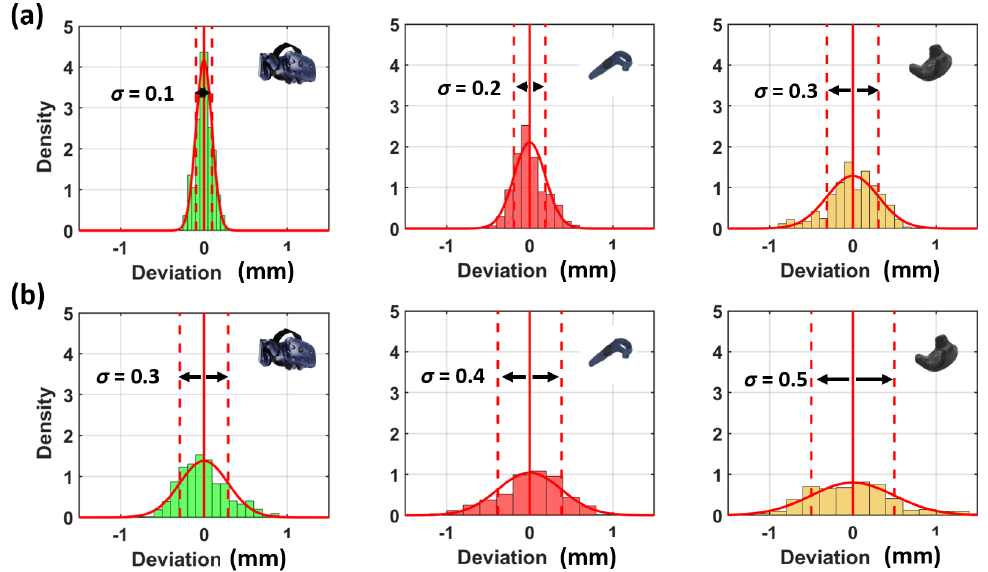
Figure 4. Histograms of the horizontal deviations ( a ) orthogonal ( b ) in direction to the lighthouse at position 2 seen in Figure 3. Standard deviation ( σ ) values are in the unit mm. Distance to lighthouse 1.8